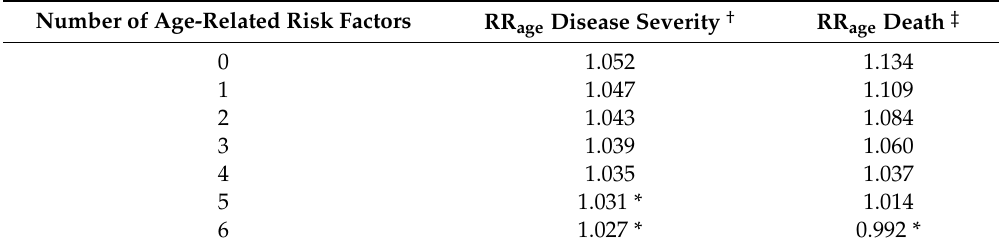
Table 6. The effect of the number of age-related risk factors included in the multivariate model on the relative risk (RR) estimate for disease severity and death. Number of Age-Related Risk Factors RR age Disease Severity †